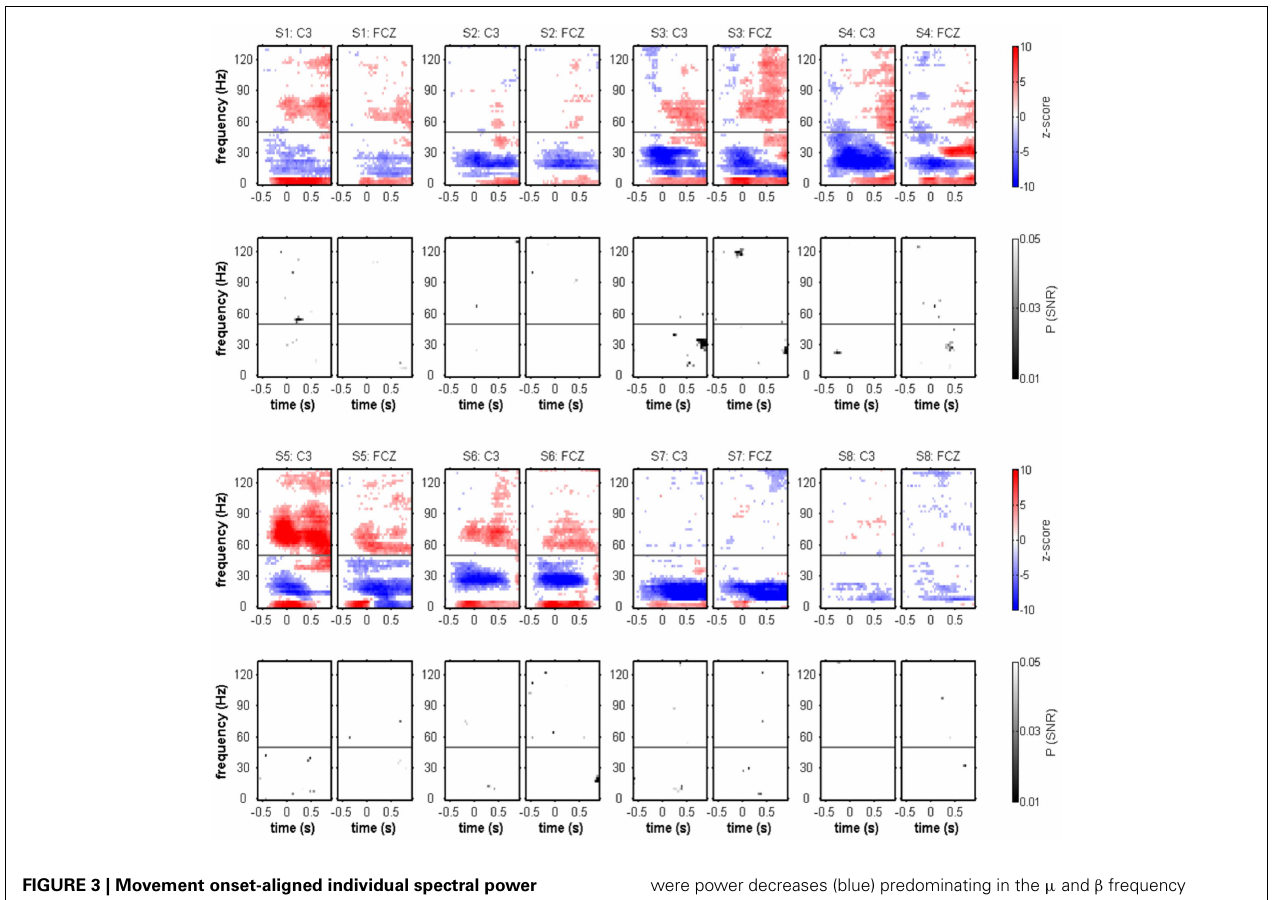
FIGURE 3 | Movement onset-aligned individual spectral power changes and SNR of movement class tuning. For each of the subjects, Z -scores of the evoked response (color-coded: movement class independent) and P -values of the movement class tuning (grayscale-coded: movement class-dependent) at the electrode positions C3 and FCZ are shown. Only significant effects ( P < 0.05, FDR-corrected) are displayed.Typical movement onset-related spectral power changes